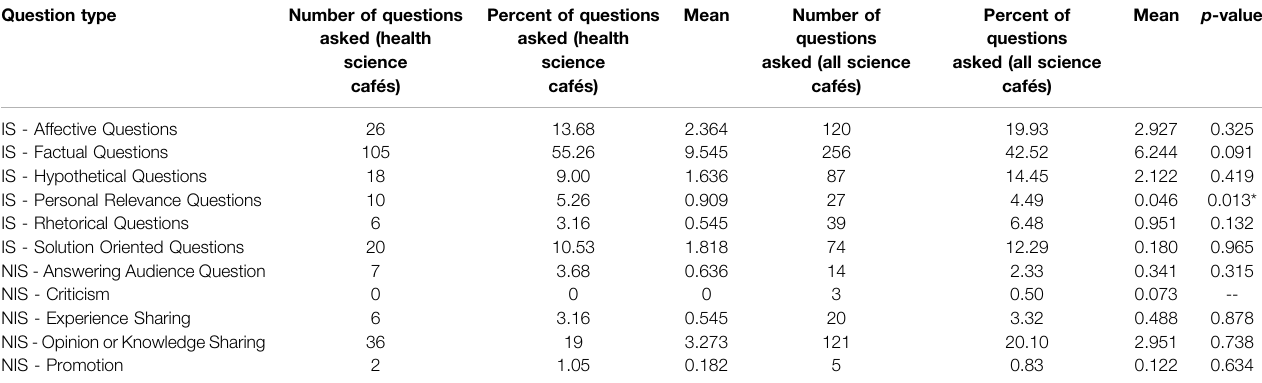
TABLE 2 | Comparison of question types at Science Café events featuring Health Topics ( n (cid:1) 11). Question type